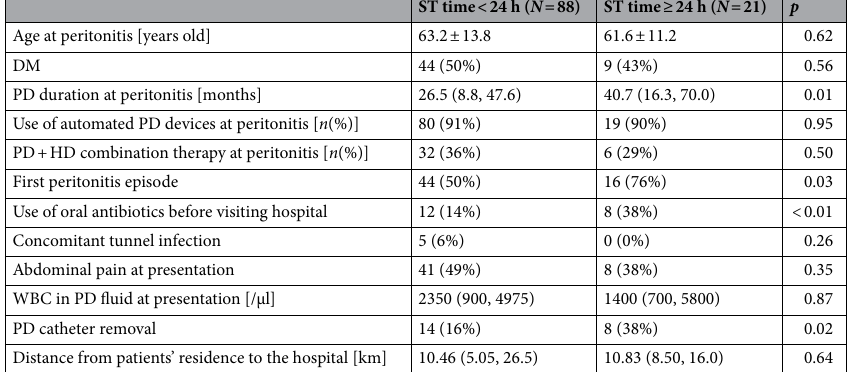
Table 3. Comparison of groups with ST time more or less than 24 h.